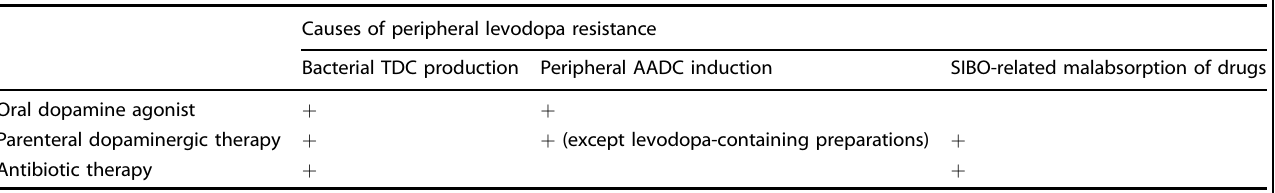
Table 1. Overview of possible therapeutic approaches to combat various causes of peripheral levodopa resistance. Causes of peripheral levodopa